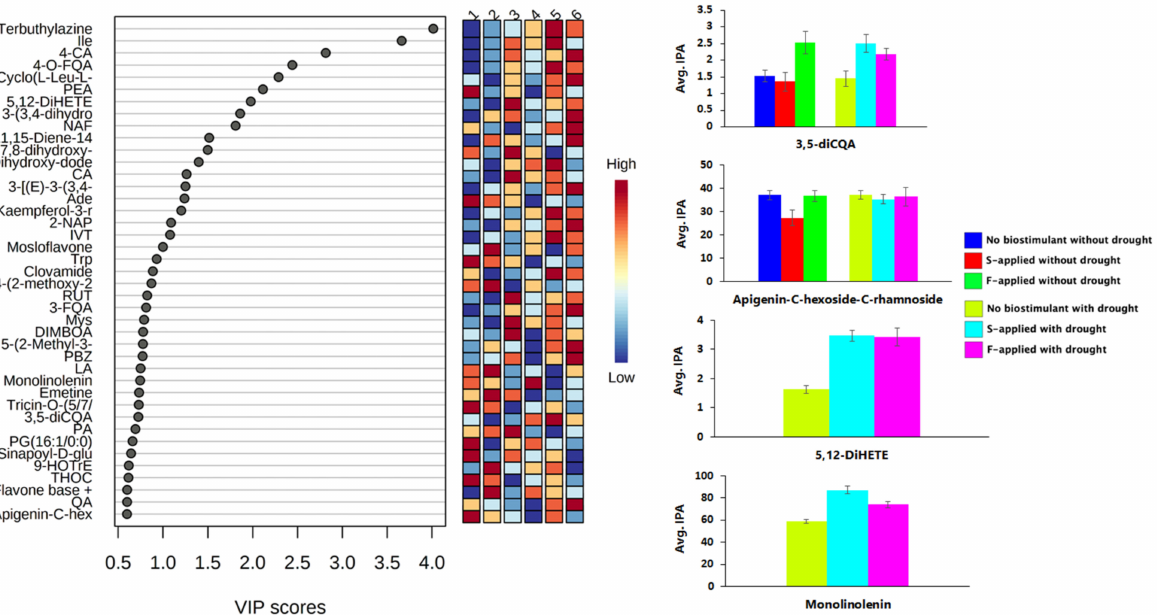
Figure 7. Visualization of discriminatory metabolites and concentration of selected metabolites in individual groups. PLS-DA VIP score plot of important identified metabolites with their concentration in each group displayed by the heatmap, and bar graphs displaying the average peak intensities of selected metabolites in each group. Abbreviation: S-applied, soil applied; F-applied, foliar applied; and Avg. IPA, averaged integrated peak area. Refer to Tables S1 and S2, Supplementary Materials, for full names of